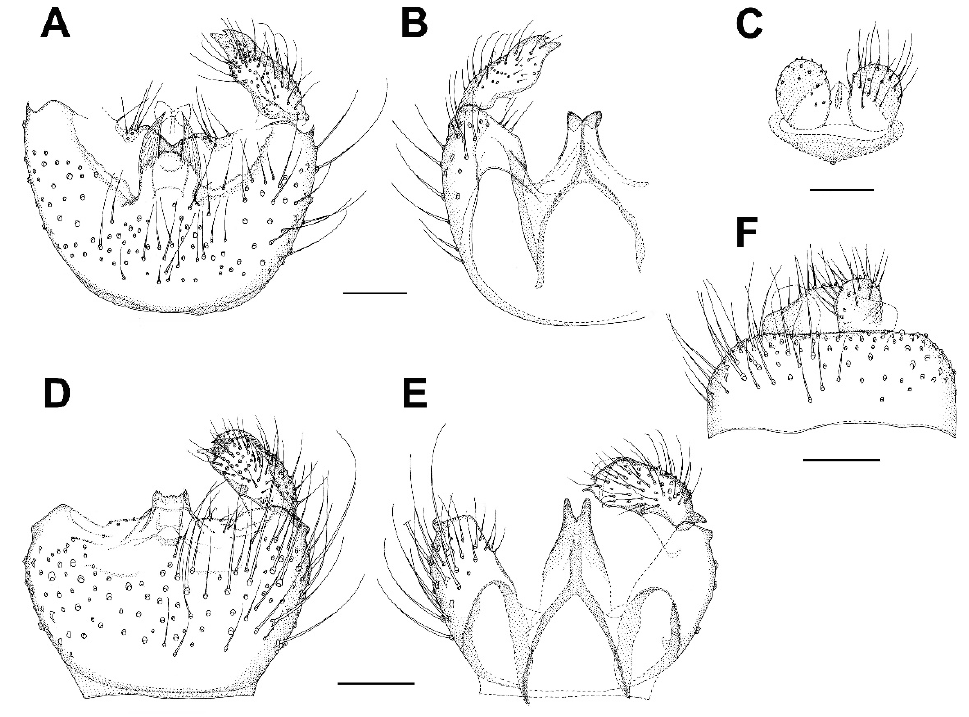
Figure 17. Male terminalia of Paratinia Mik. Paratinia furcata sp. nov. (holotype): ( A ) ventral view, ( B ) dorsal view; ( C ) cerci; P. sciarina Mik (Slovakia), ( D ) ventral view, ( E ) dorsal view, ( F ) tergite 9 and cerci. Scale bars: 0.1 mm.